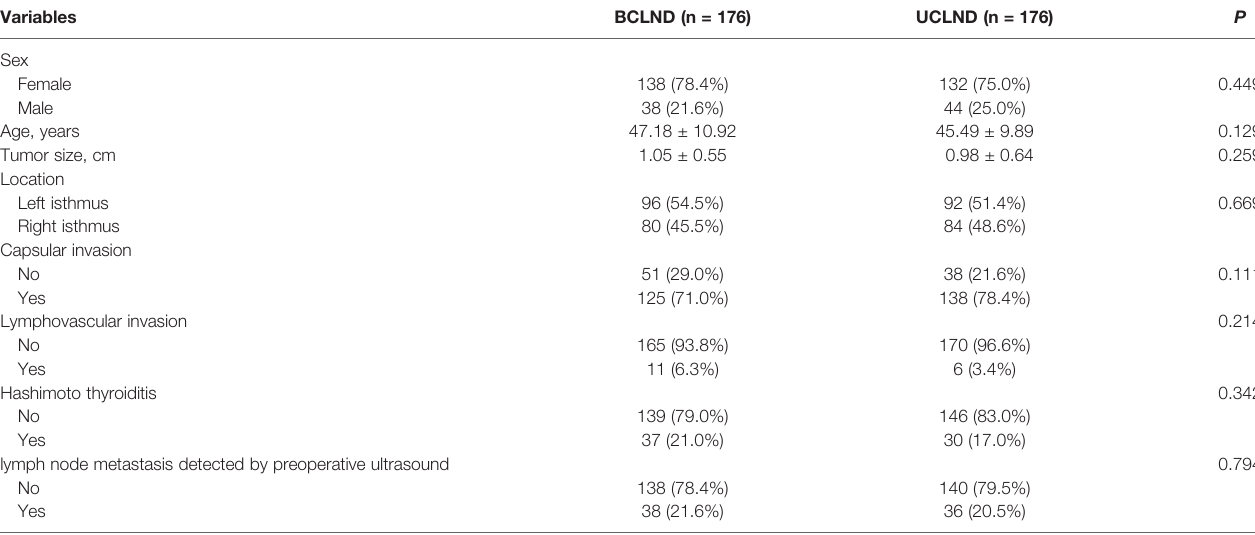
TABLE 1 | Baseline clinicopathological characteristics of patients with PTC located at isthmus with BCLND or UCLND after propensity score matching.